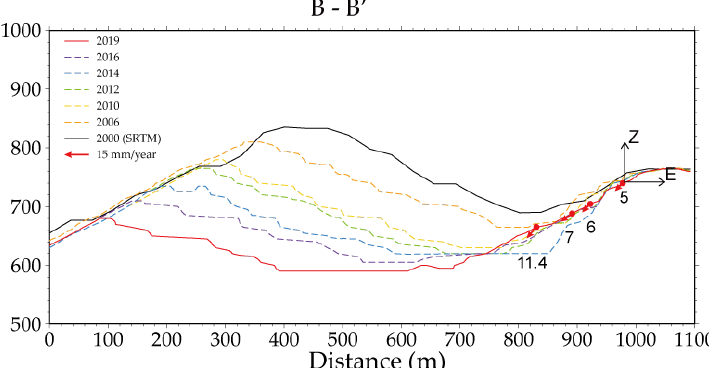
Figure 6. The resulting images of the mining area. ( a ) Elevation change, ( b ) RGB composited coher- ence image, ( c ) PSInSAR points from ascending (triangle) and descending (circle) orbit overlying a Figure 7. Elevation changes and displacements along the B- B’ cross -section in the mining area. Note the displacement arrows are in vertical-east plane. Except for SRTM, the rest of the DEM was ob- tained from the National Geographic Information Service of Korea.